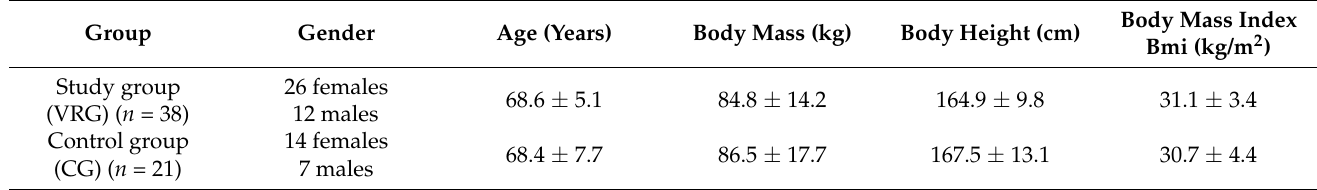
Table 1. Characteristics of the participants (mean ±